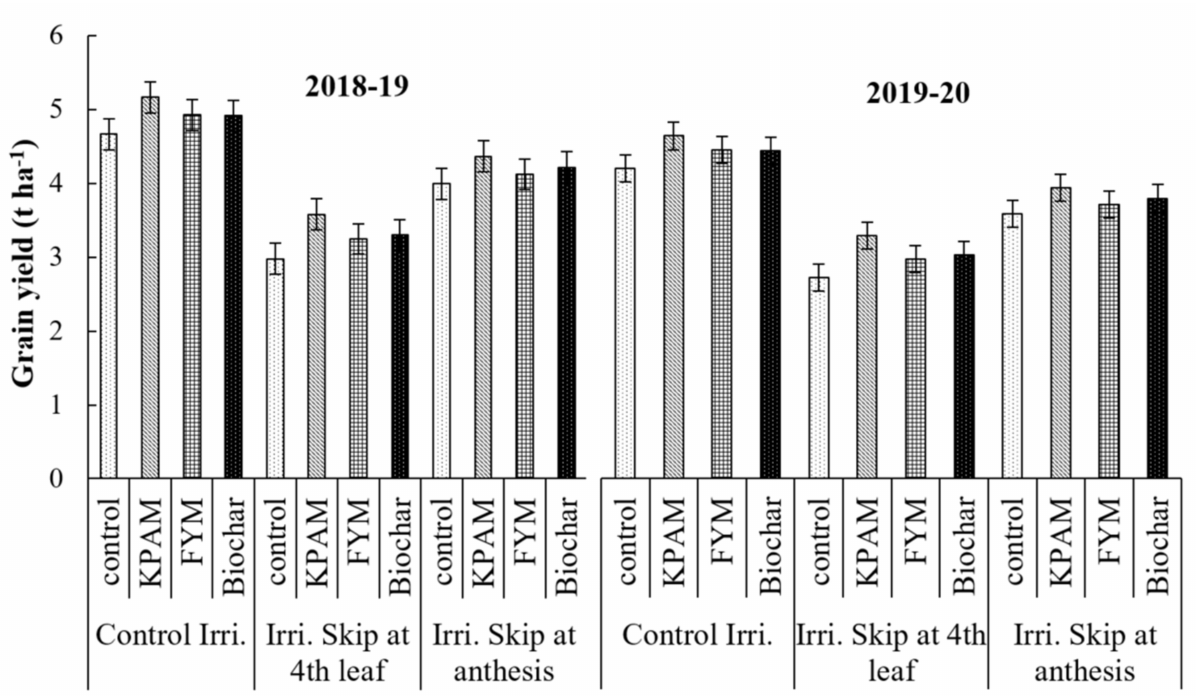
Figure 12. Effect of soil amendment materials on biological yield in the wheat crops grown under normal and water stress imposed by skipping irrigation at 4th leaf and anthesis stage of growth (mean values ± S.E).